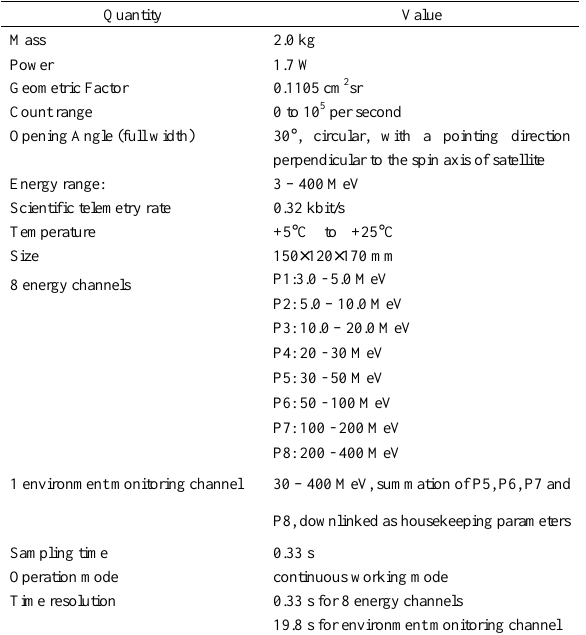
Table 3. Instrument data summary of